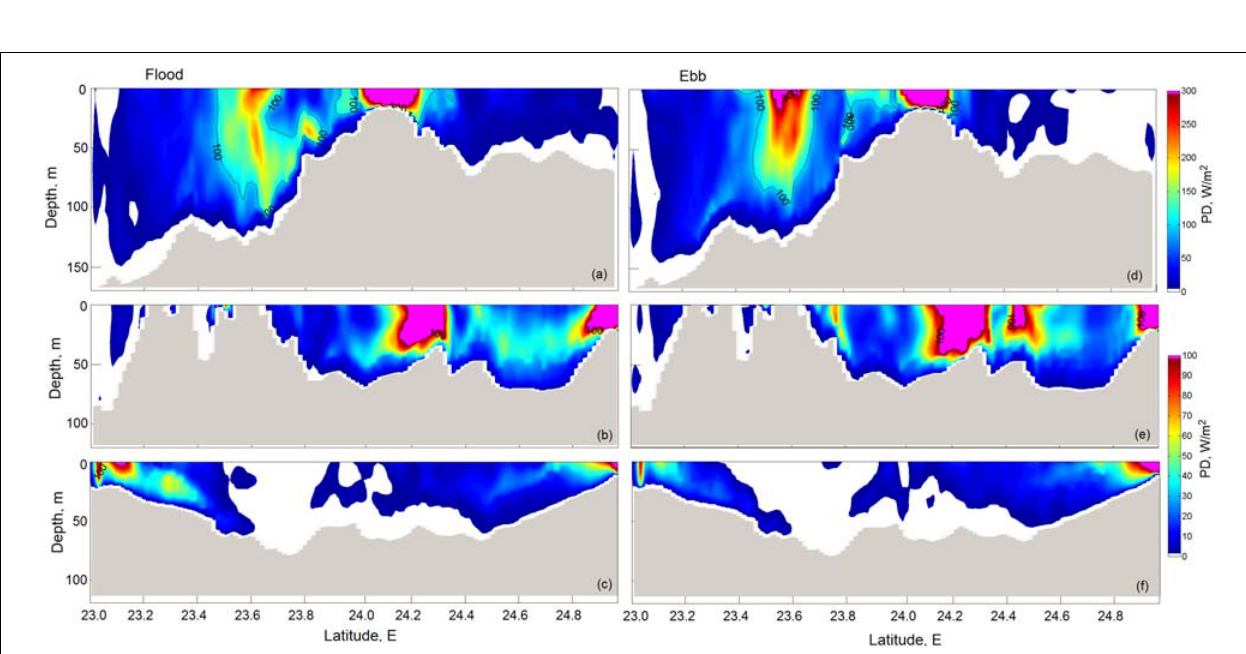
Frontiers in Marine Science |